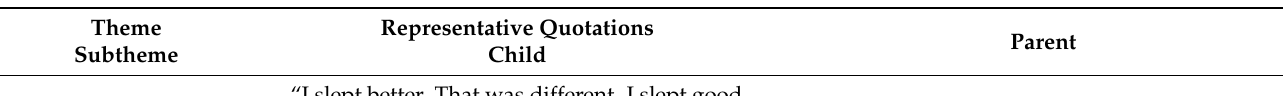
Table 4. Favorable responses to sugary drink cessation reported during qualitative interviews with participants and their parents; n = 30